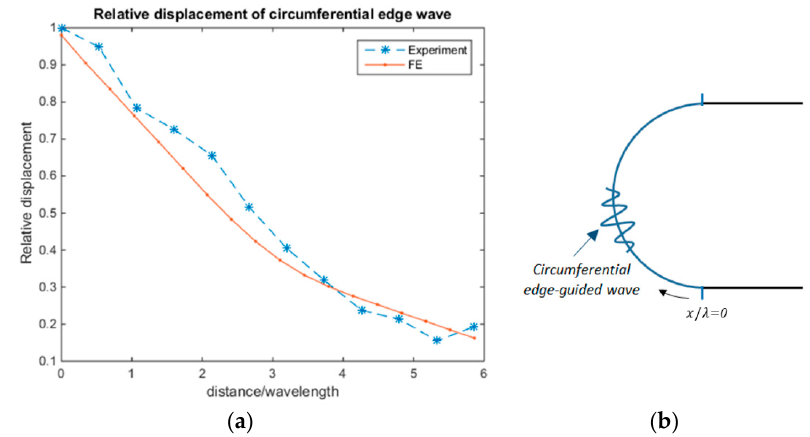
Figure 5. ( a ) The experimental and finite element (FE) attenuation of incident circumferential edge wave displacement over the curved surface; and ( b ) Circumferential edge wave measurements taken on the curved edge (blue semi-circle) starting at the 6 o’clock position and ending at the 12 o’clock position.